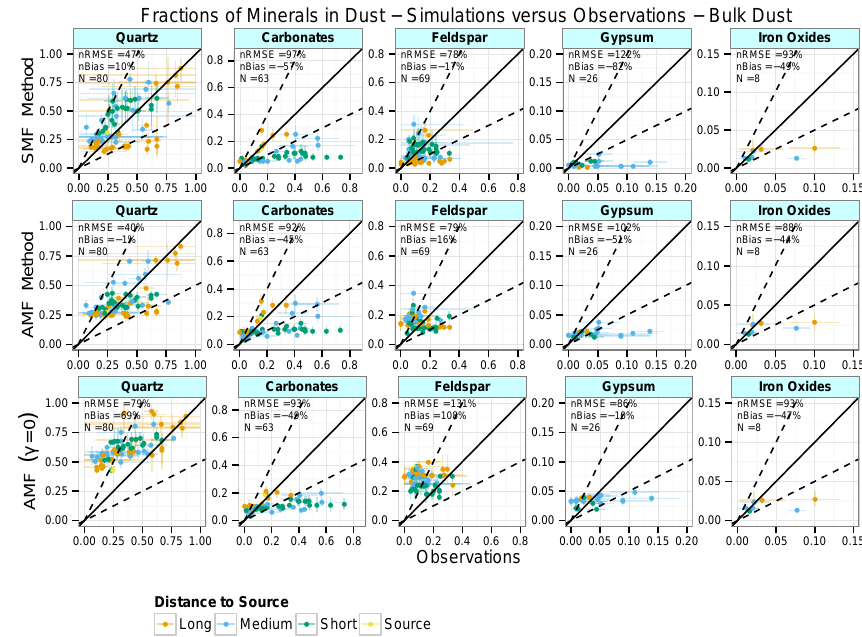
Figure 7. Same as Fig. 4 but for bulk mineral fractions of quartz, carbonates, feldspar, gypsum, and iron oxides.